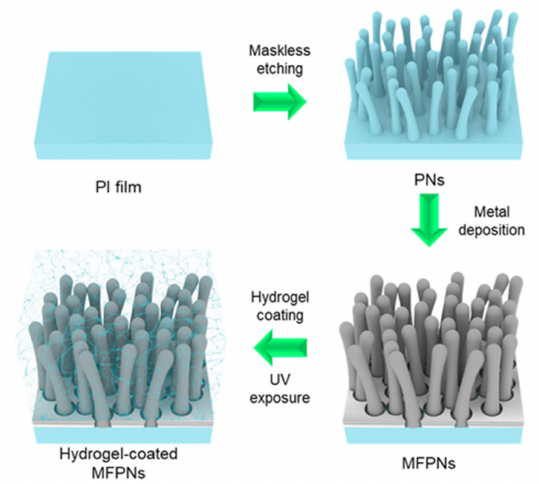
Scheme 1. Fabrication procedure for the hydrogel-coated MFPN SERS